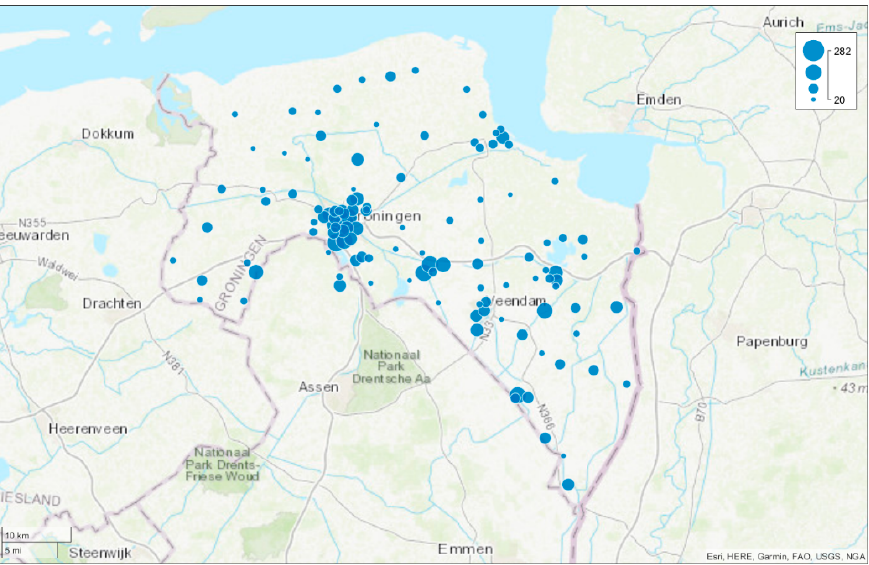
Figure 2. The spatial distribution of customer complaints in the province of Groningen between February 2013 and January 2021. The size of the blue nodes indicates the number of reports within this